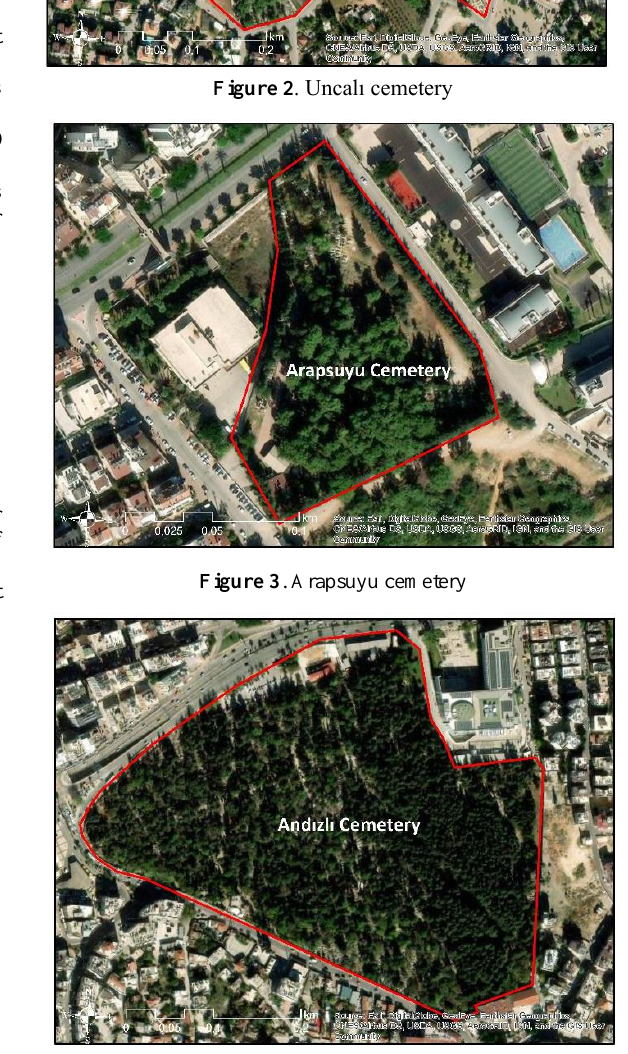
Figure 1 . Study area